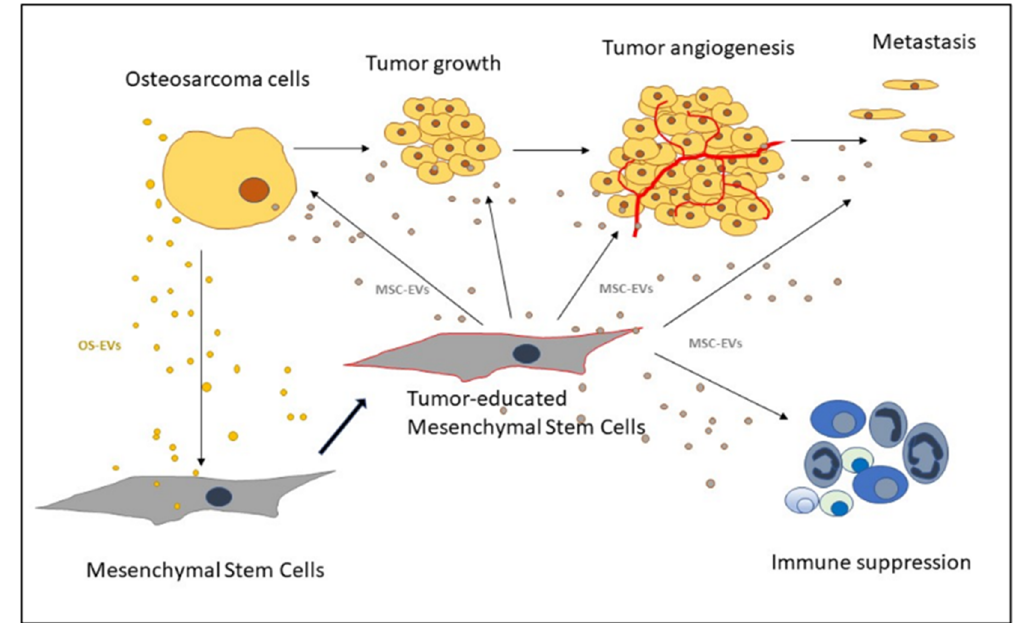
Figure 1. Schematic representation of extracellular vesicles (EVs)-mediated communication between mesenchymal stem cells and osteosarcoma cells (OS) in the OS microenvironment.